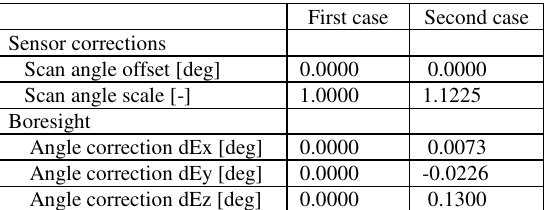
Table 2. Initial system and installation parameter values